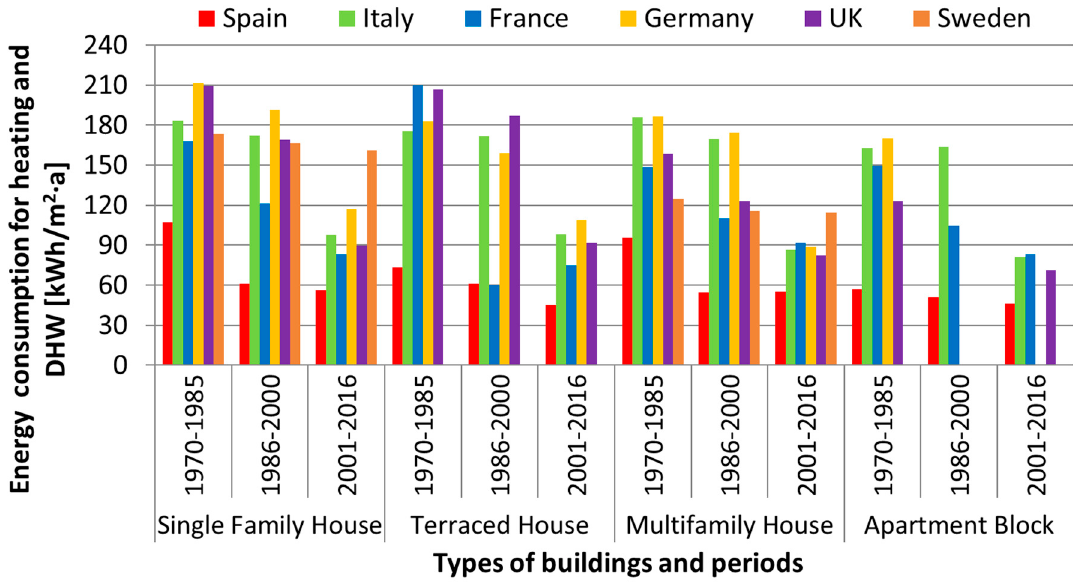
Figure 6. Energy consumption for heating and domestic hot water in temperate climate conditions by country.